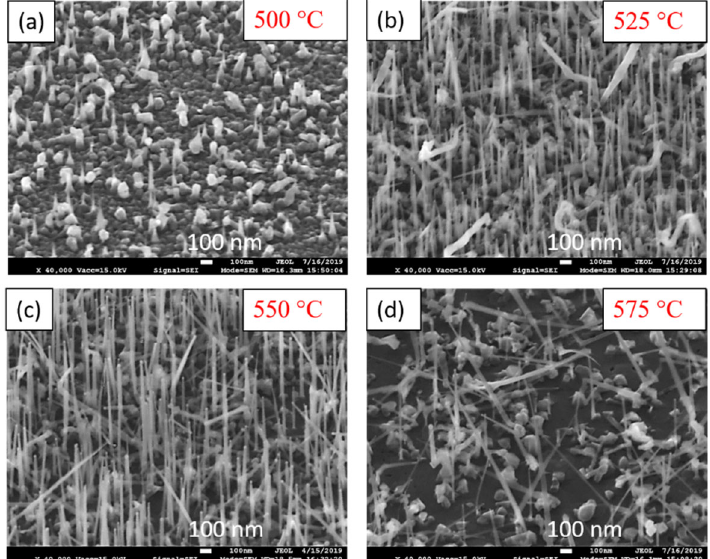
Figure 5. 45° ‐ tilted SEM image of samples prepared on GaAs (111)B sustaining R VI/II = 2 at different temperatures: ( a ) 500 °C, ( b ) 525 °C, ( c ) 550 °C and ( d ) 575 °C. temperatures: ( a ) 500 ◦ C, ( b ) 525 ◦ C, ( c ) 550 ◦ C and ( d ) 575 ◦